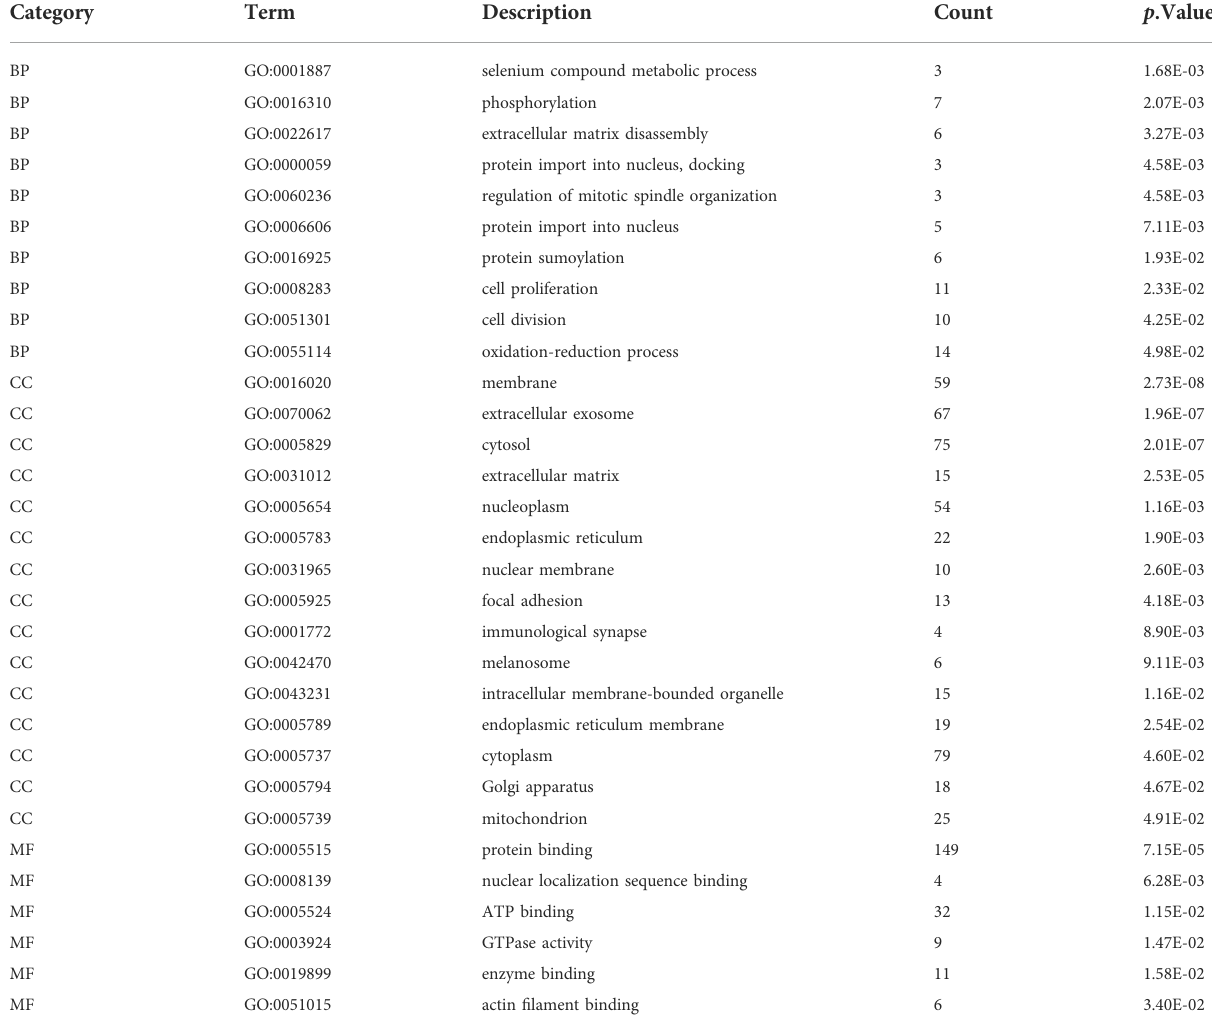
TABLE 1 Gene ontology enrichment analysis of hypomethylated upregulated